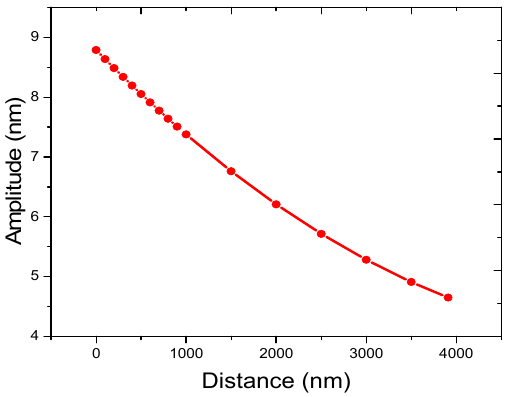
Figure 7 . Amplitude versus different values of distance between the AFM tip and SMR. Figure 7. Amplitude versus different values of distance between the AFM tip and SMR.